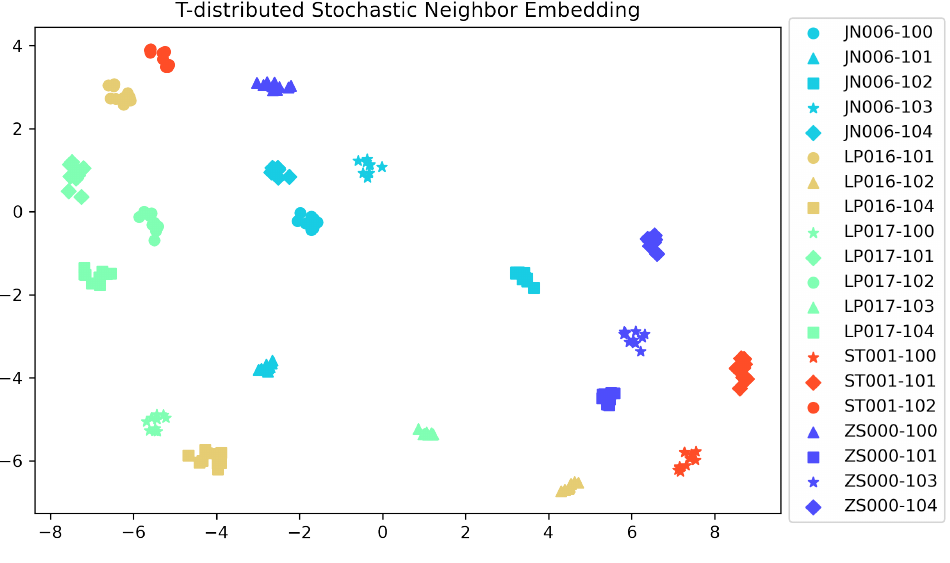
Figure 9. t-SNE visualization for the embedding vectors corresponding to three to five customized facial motions from five subjects in our